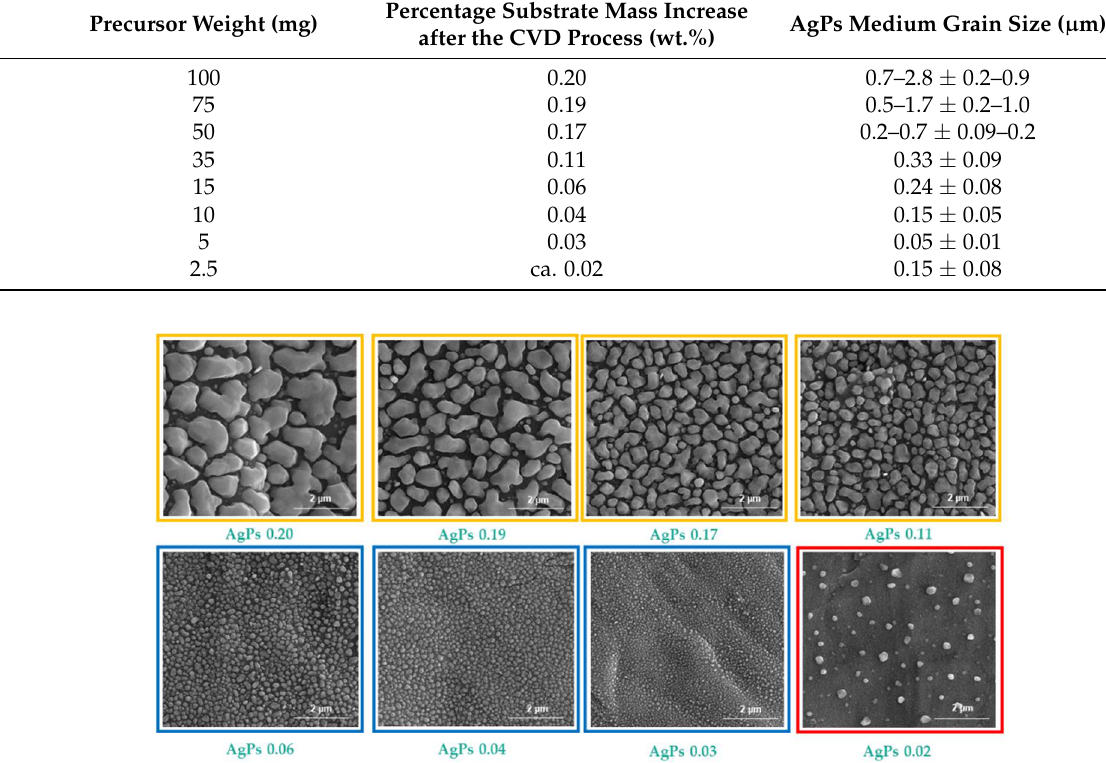
Table 2. AgNPs films deposited by CVD technique.